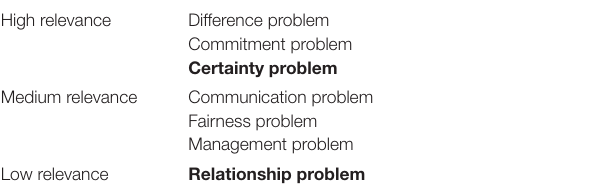
TABLE 4 | Seven main problems of research